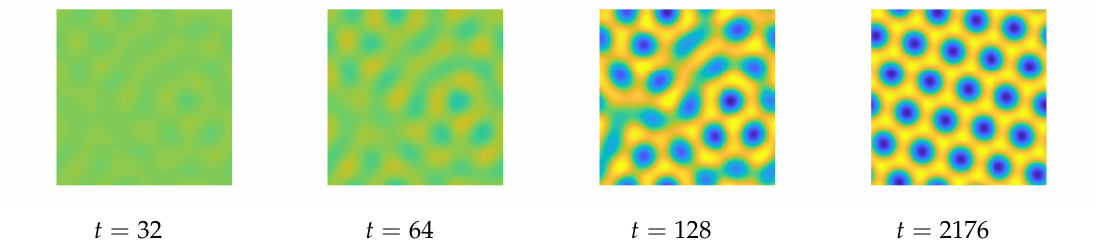
Figure 5. Evolution of φ ( x , y , t ) using the method S3 with ( ¯ φ , (cid:101) ) = ( 0.14,0.1 ) . In each snapshot, the yellow, green, and blue regions indicate φ = 0.3926, 0.0108, and